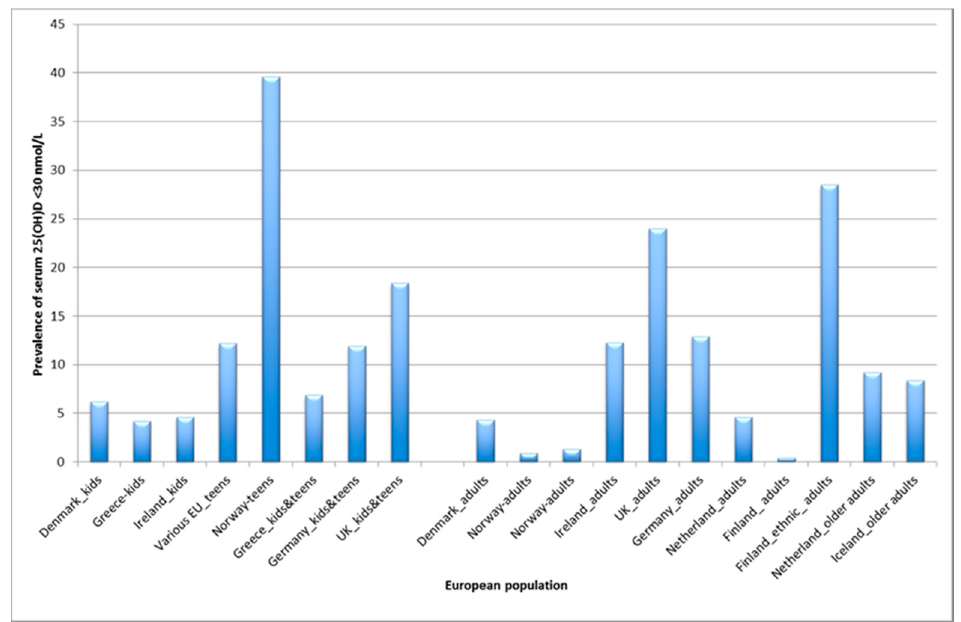
Figure 1. Prevalence of vitamin D deficiency (serum 25(OH)D < 30 nmol//L) in European young and adult/older adult, populations (adapted from Cashman et al [14]).